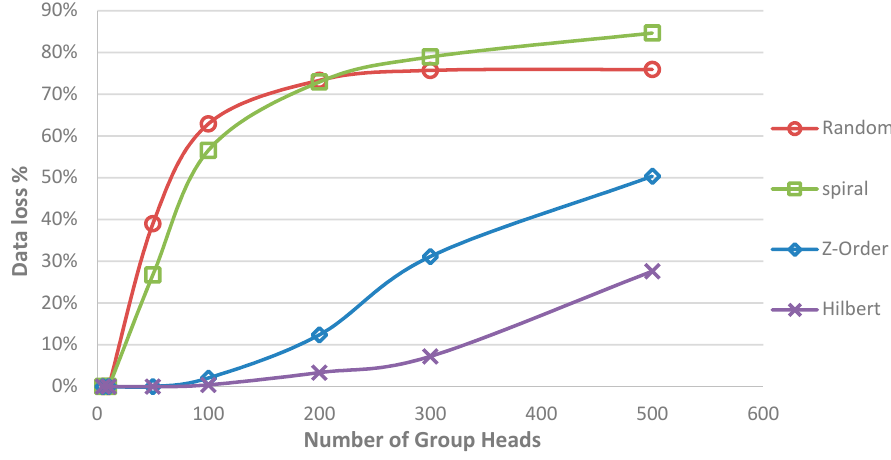
Figure 4. Comparing the percentage of data loss using different orderings of GHs